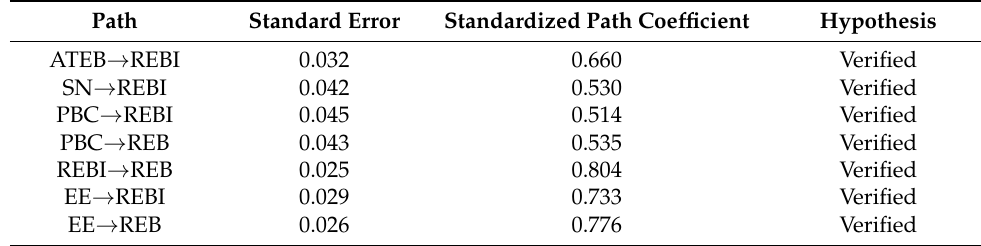
Table 9. Path analysis of the structural model.